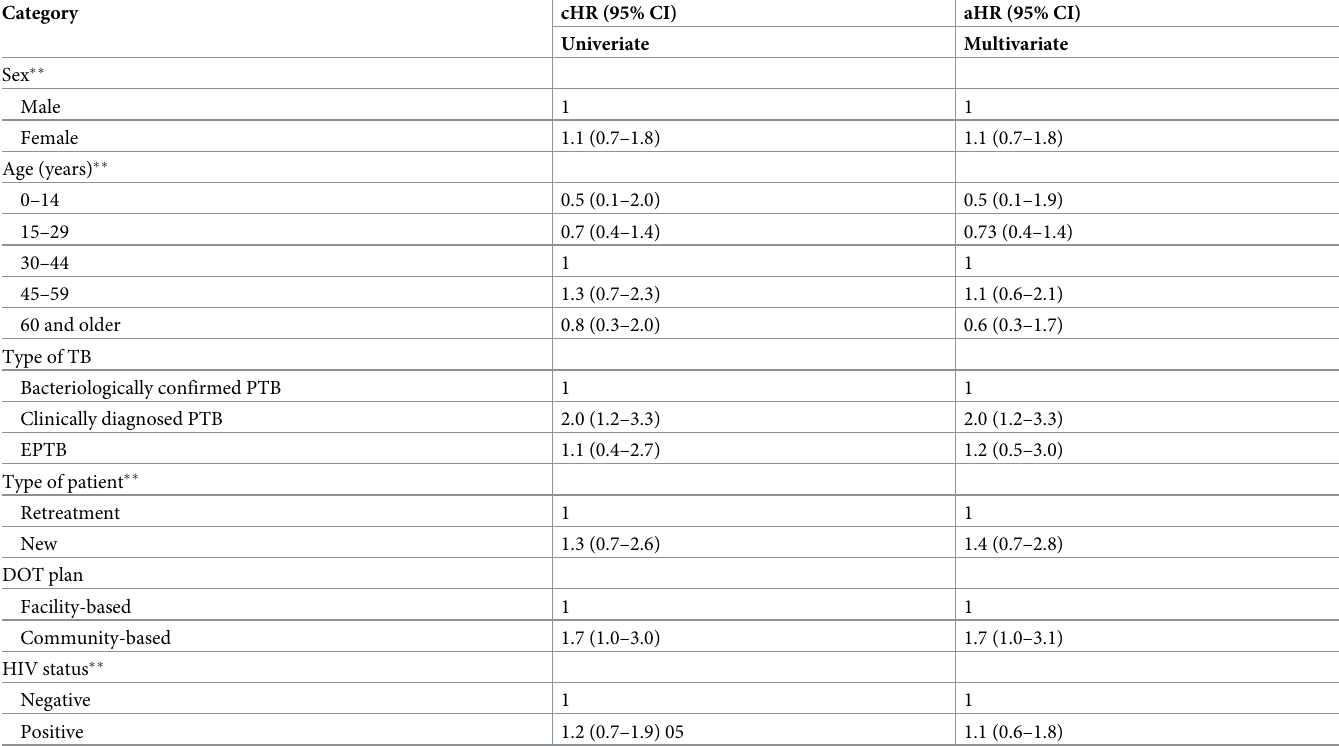
Table 5. Characteristics associated with TB mortality in Itezhi-Tezhi District (2015–2018), n = 426. Category